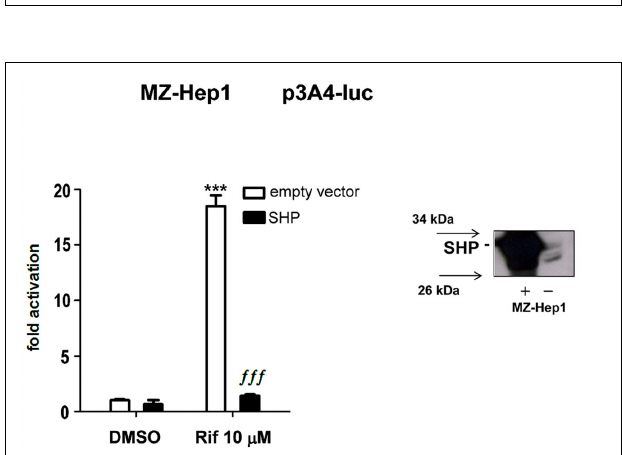
FIGURE 2 | Pregnane X receptor activation with rifampicin (10 μ M) has no effect on SHP protein expression in primary human hepatocytes. Primary human hepatocyte cultures were treated with rifampicin (Rif, 10 μ M) for 24 (A) or 48h (B) . SHP protein levels were analyzed byWestern blotting with specific antibody.